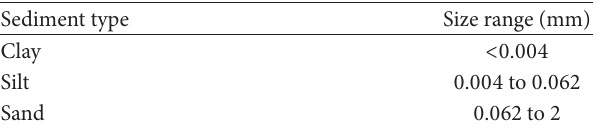
Table 1: Sediment classification according to